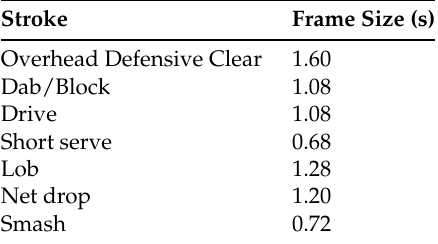
Table 4. Best frame size by stroke